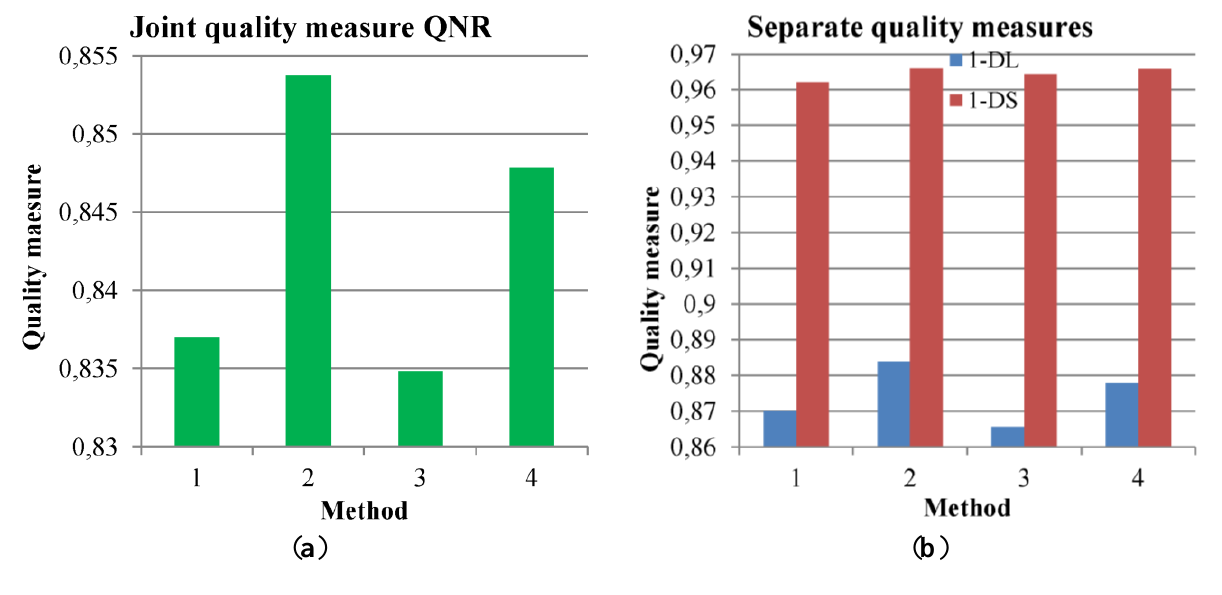
Figure 4. QNR quality assessment of interpolation methods: 1—NN, 2—ZP, 3—BIL, and 4—CUB for WV-2 data. ( a ) QNR, ( b ) 1− DL and 1− DS